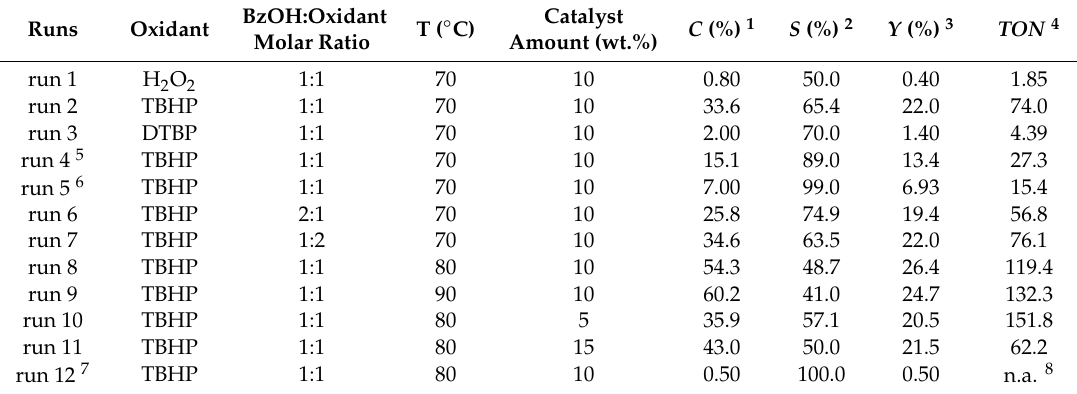
Table 5. Catalytic performance optimization of Ce-MCM-Cl for benzyl alcohol oxidation.